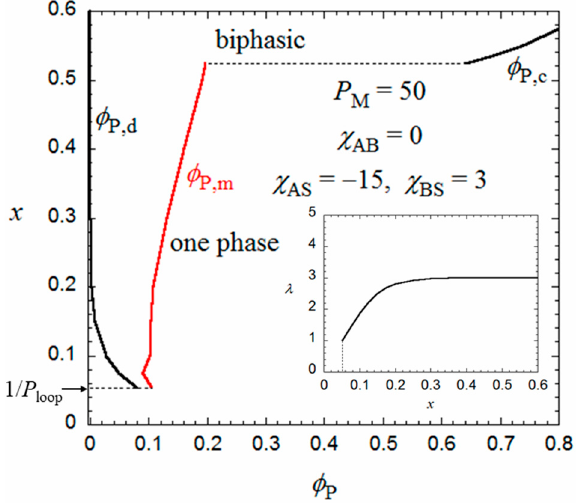
Figure 4. Monomer content-concentration phase diagram for an aqueous solution of a random copolymer with P M = 50 and the same interaction parameters as those used in Figures 2 and 3.